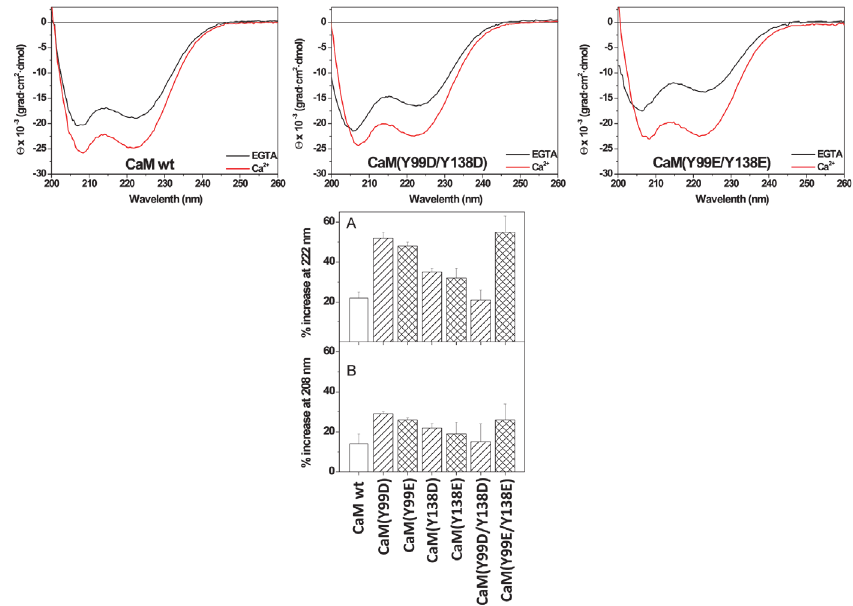
Fig 3. Ca 2+ -induced changes in the far-UV circular dichroism spectra of the different CaM species. ( Top panels ) Far-UV CD spectra for wild type ( wt ) and the double Y/D and Y/E CaM mutants (118 μ M) were recorded at 20°C in 20 mM Tris-HCl (pH 7.5), 0.1 M KCl, containing 1 mM EGTA (black lines) or 1 mM CaCl 2 (red lines). ( Bottom panels ) The mean ± SEM (n = 3) increase in ellipticity in the far-UV circular dichroism signals at 222 nm ( A ) and 208 nm ( B ) of the indicated CaM species is represented as percentage taking as 100% the ellipticity of each CaM species in the presence of EGTA. Measurements were carried out at 20°C in 20 mM Tris-HCl (pH 7.5), 0.1 M KCl, containing 1 mM EGTA or 1 mM CaCl 2 , respectively. The concentration of CaM was 12 μ M ( A ) and 118 μ M ( B ).